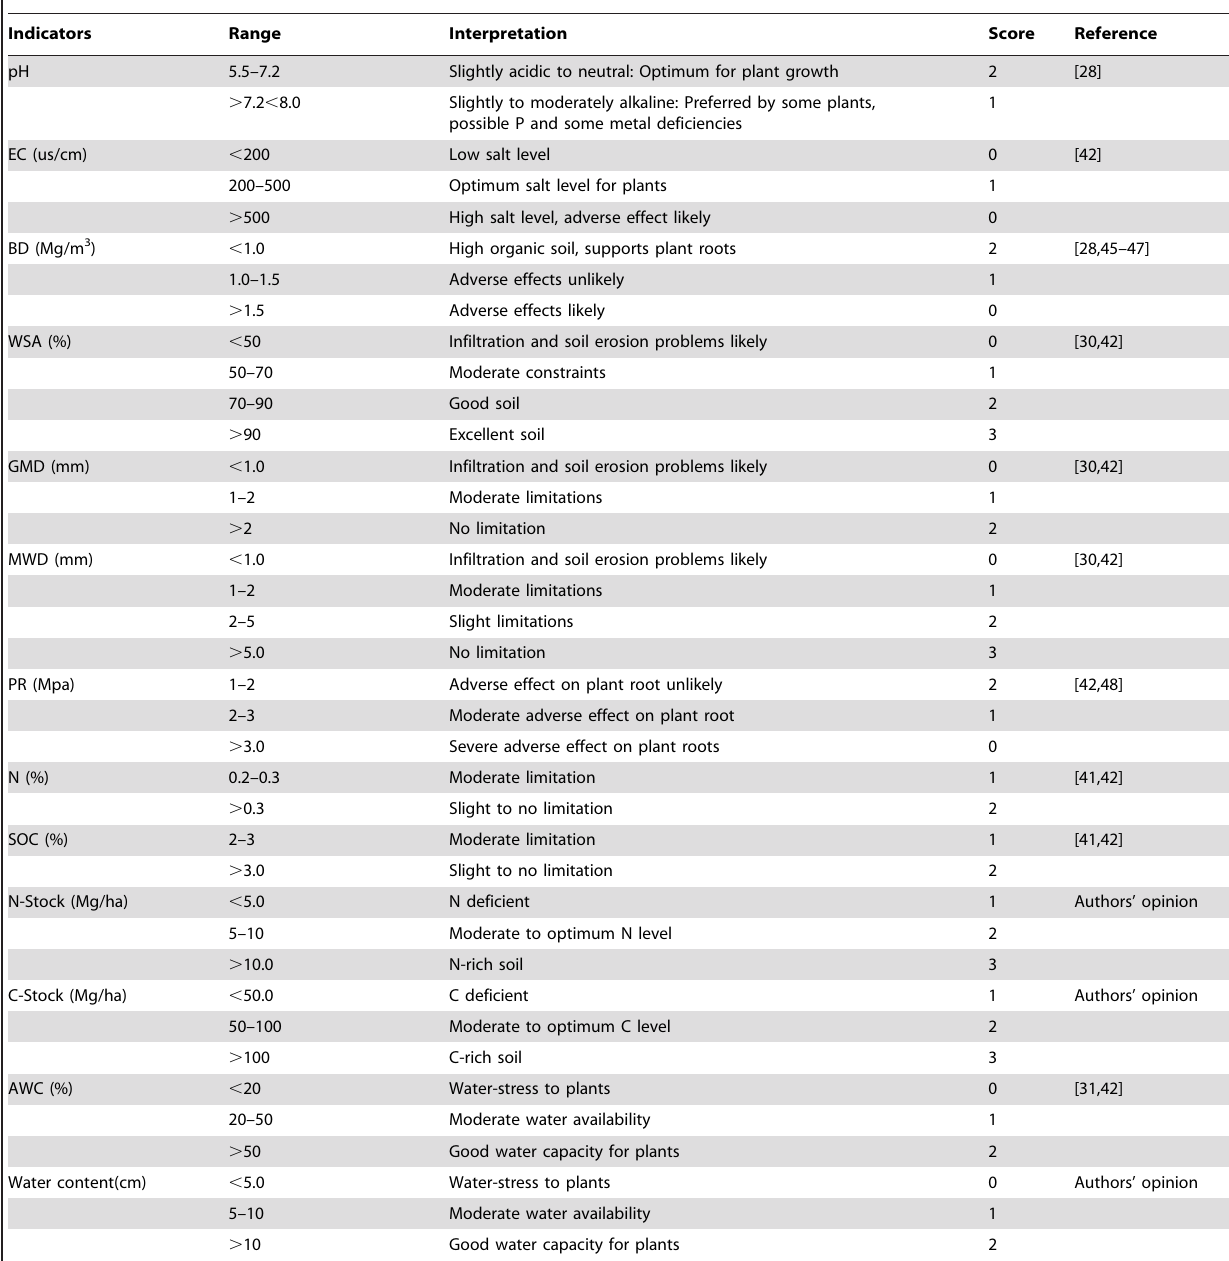
Abbreviations are same as Table 1.